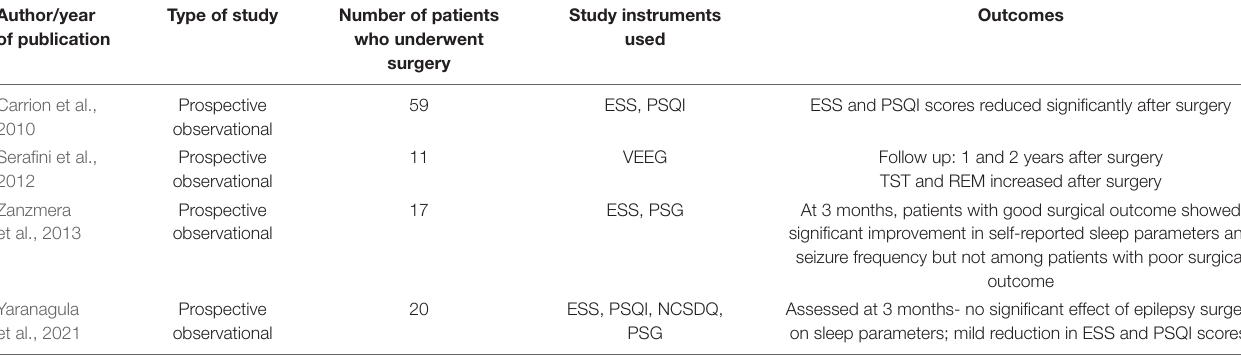
TABLE 7 | Studies assessing the impact of epilepsy surgery on sleep parameters among patients with